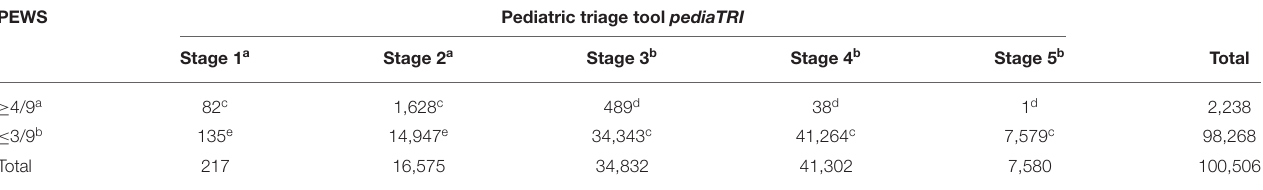
TABLE 3 | Agreement in triage between pediaTRI vs. PEWS in screening “high-level emergency” and “low-level